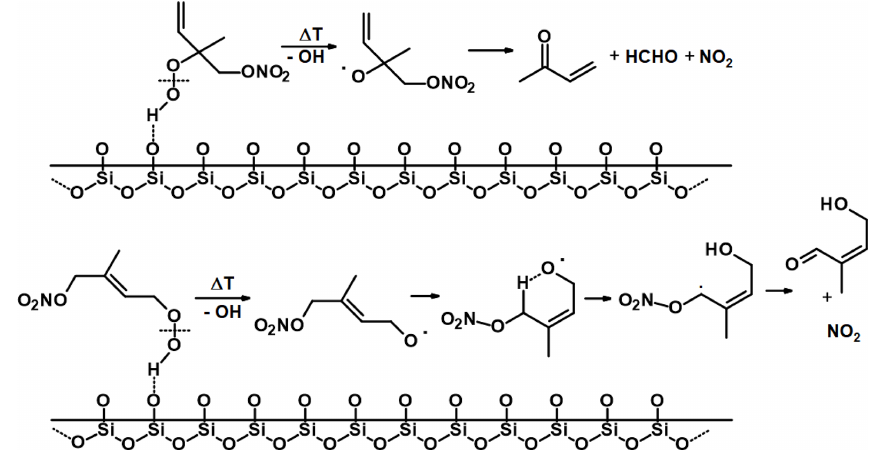
Figure 11. Potential degradation pathways of isoprene-derived hydroperoxides on a heated quartz